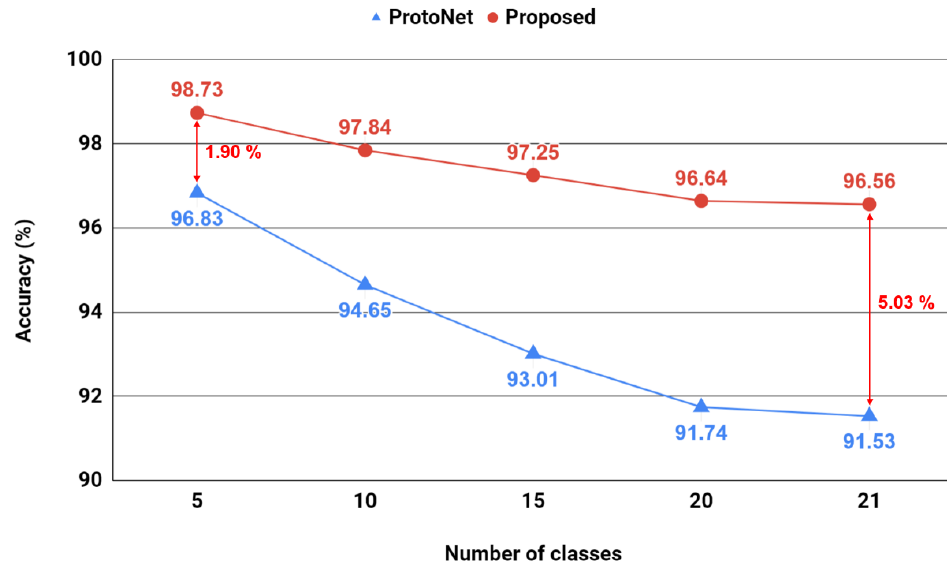
Figure 9. Change of Classification accuracy on GTSRB depending on the number of ways. Table 2. The 1-shot classification accuracies on GTSRB. The values marked with * are quoted from the VPE paper [15], and the ones with ** are measured by experiments using codes provided by the authors [9].